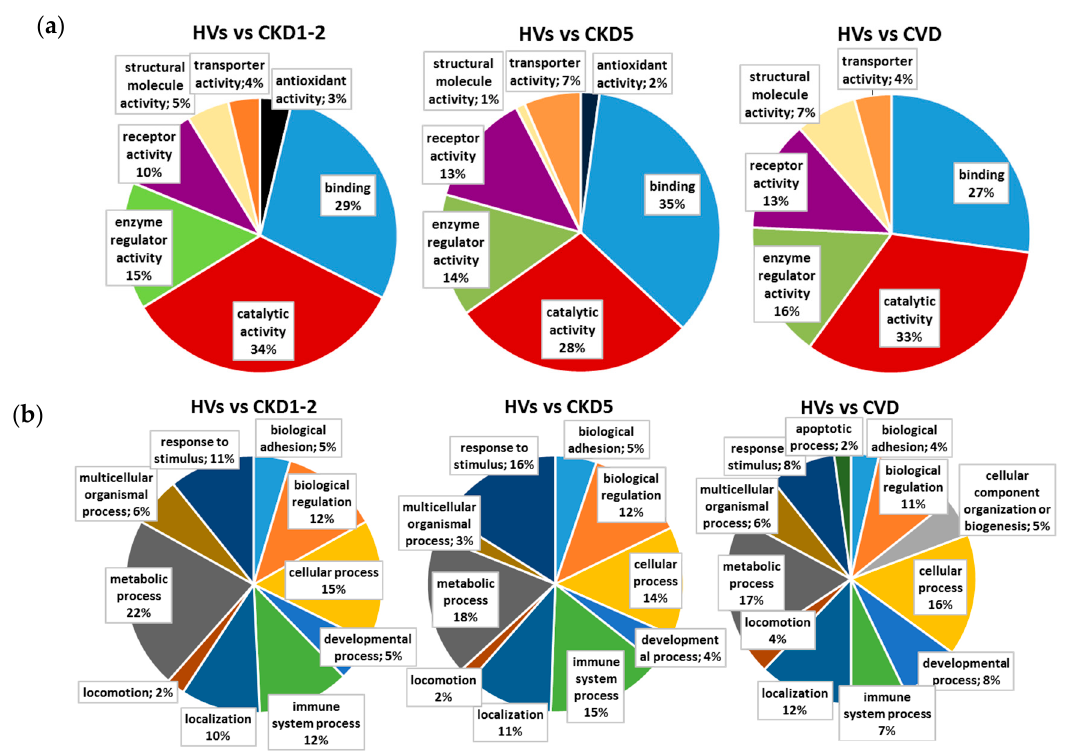
Figure 2. Classification of the identified differentially expressed proteins in molecular function ( a ) and biological processes; ( b ) on the basis of gene ontology (GO) annotations with p < 0.05. Table 2. Top pathways enriched in the differentially expressed proteins—results from DAVID (Database for Annotation, Visualization, and Integrated Discovery). NS: non-significant.